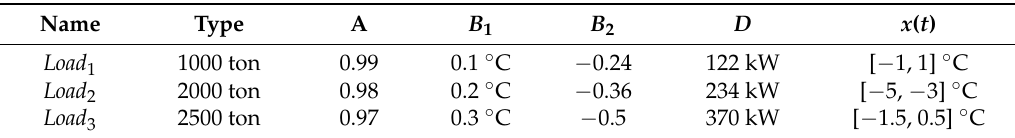
Table 4. Parameters of flexible loads in three refrigerators.